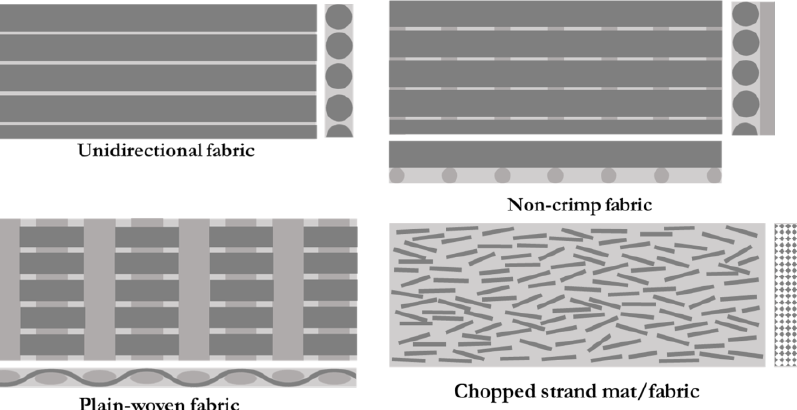
Figure 5. Commonly fabric architectures used to manufacture basalt fibre reinforced